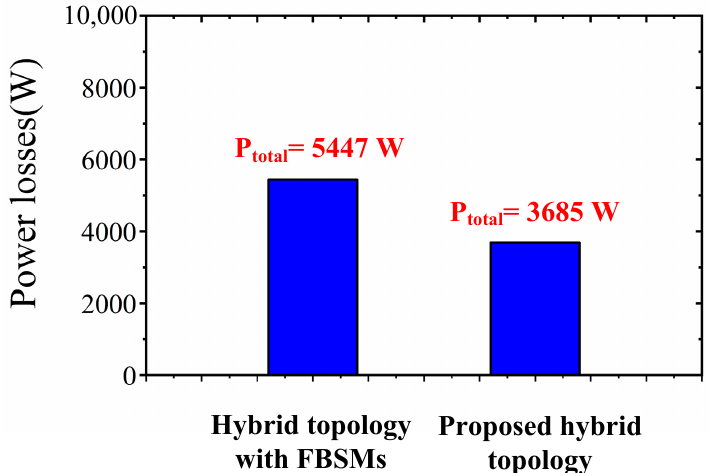
Figure 18. Power losses of the hybrid MMC with FBSM on the AC side and the proposed hybrid MMC.